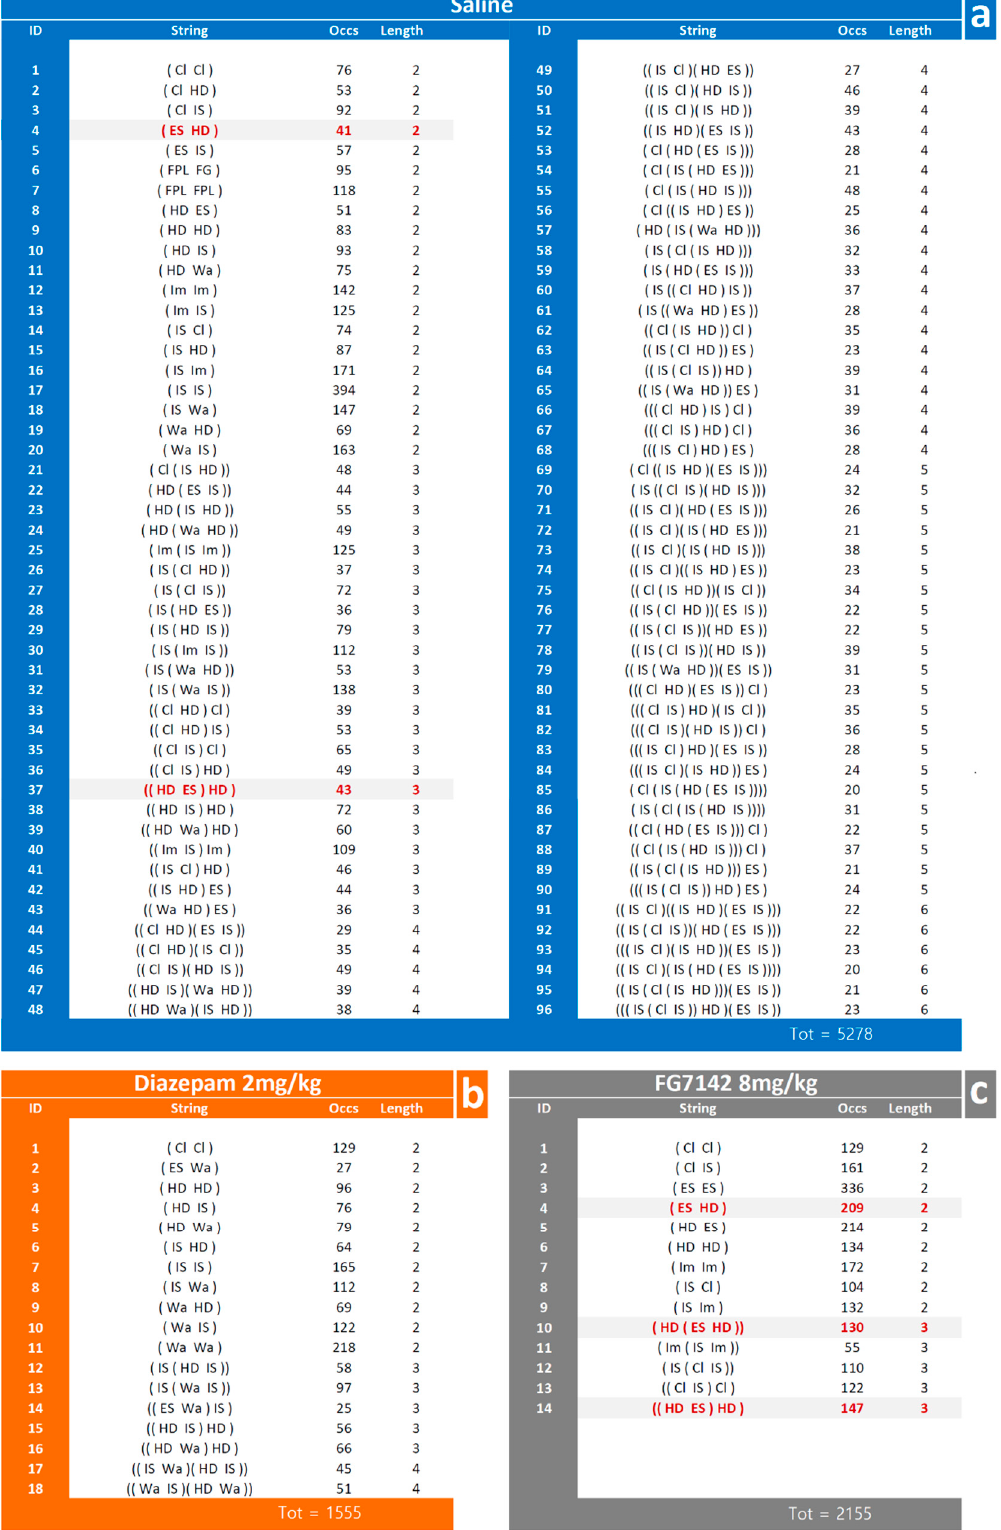
Figure 8. Terminal strings of the T-patterns detected in saline ( a ), diazepam 2 mg/kg ( b ) and FG7142 8 mg/kg ( c ) groups. The number on the left of each string indicate the corresponding T-pattern; numbers on the right of each string indicate their length and overall occurrences (Occs column). Highlighted in light grey: T-patterns containing Edge-Sniff → Head-Dip transitions. Data obtained from the analysis of three groups each encompassing 10 subjects. See Figure 1 for abbrevi- ations.